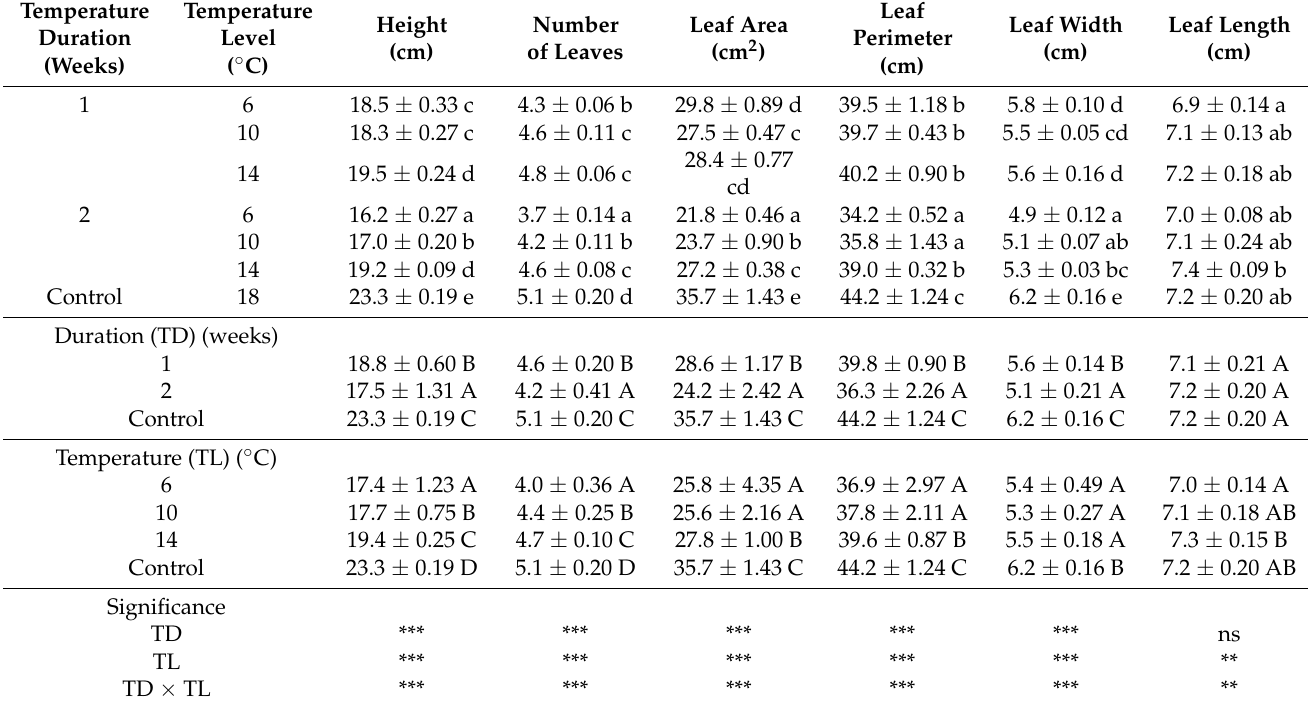
Table 1. Effect of low-temperature treatment on morphological parameters of broccoli